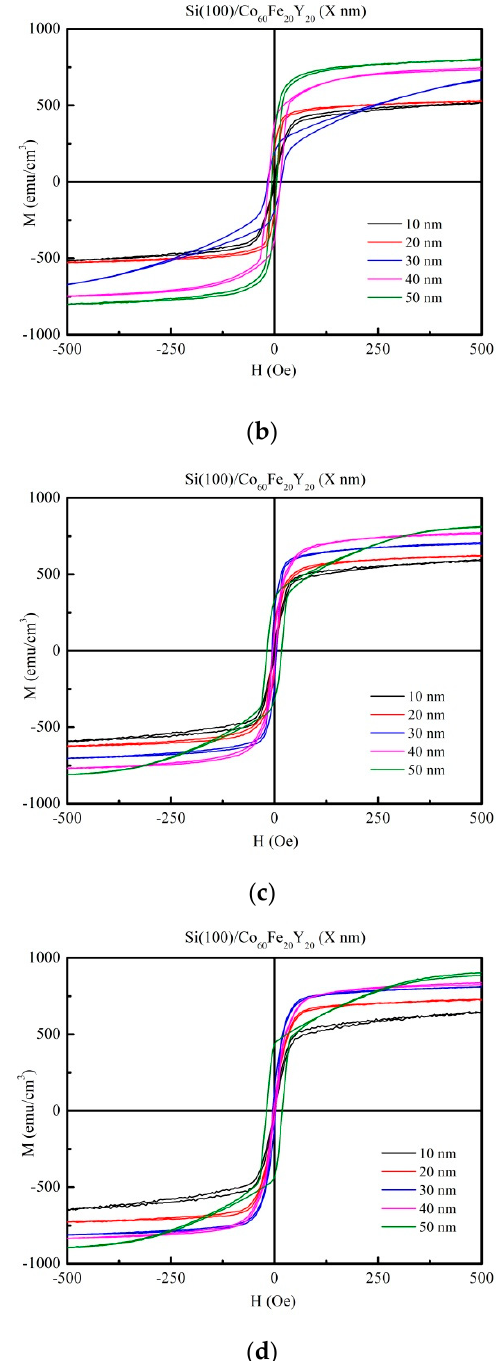
Figure 2. In-plane magnetic hysteresis loop of CoFeY thin films. ( a ) RT, ( b ) post-annealing at 100 °C, ( c ) post-annealing at 200 °C, and ( d ) post-annealing at 300 °C.